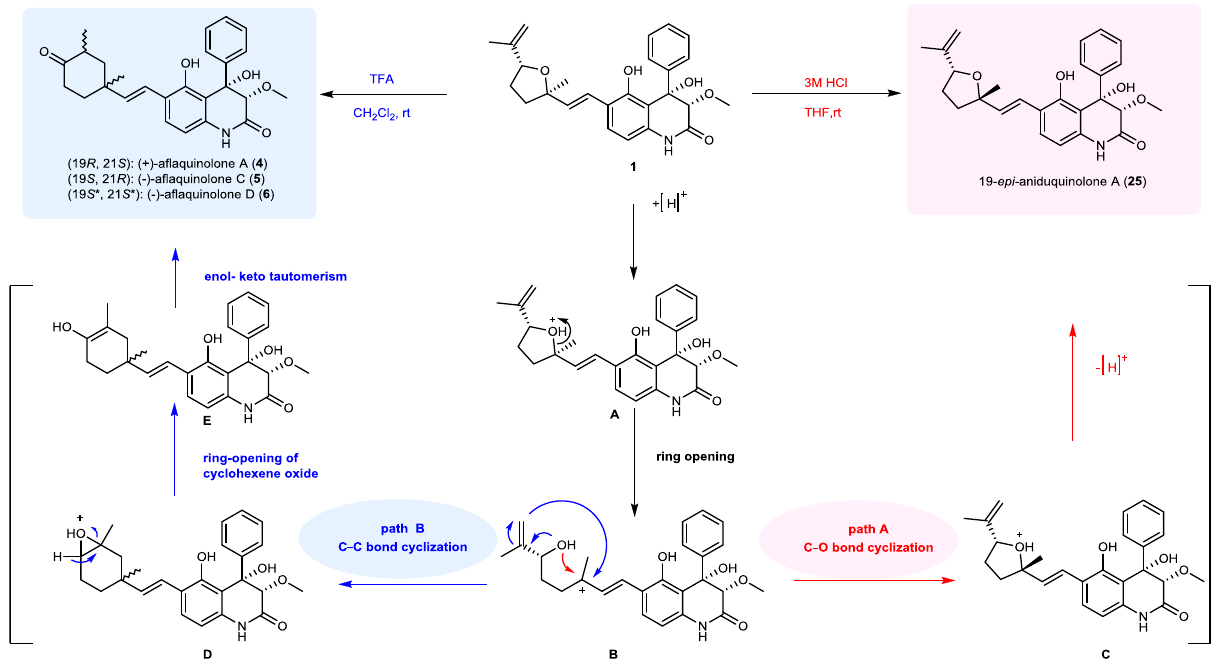
Fig. 6 Proposed mechanism. The acid-catalyzed rearrangement from aniduquinolone A to 19- epi -aniduquinolone A and a fl